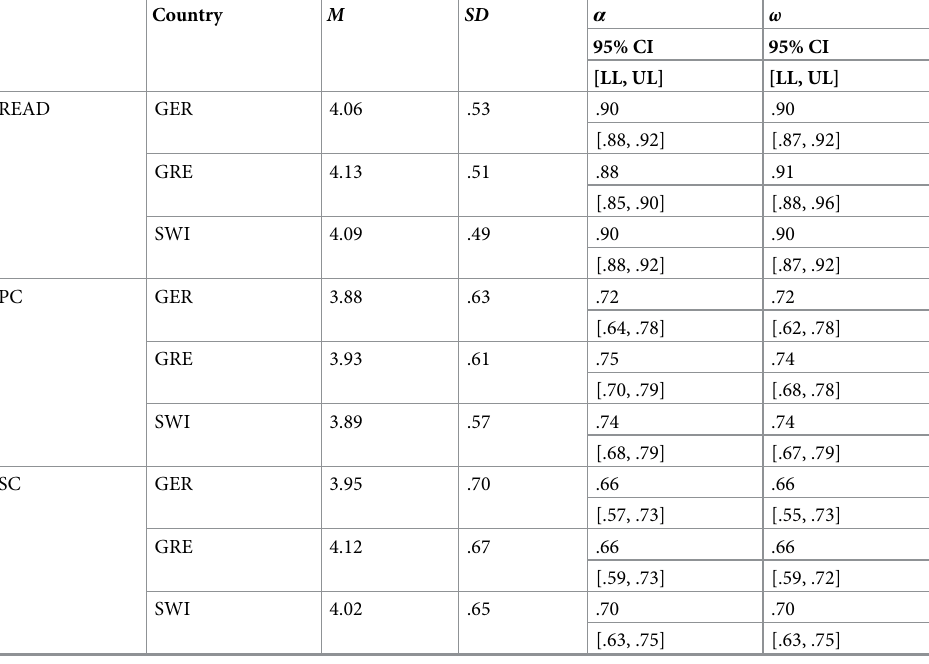
Table 1. Means, standard deviations, Cronbach’s alpha, McDonald’s